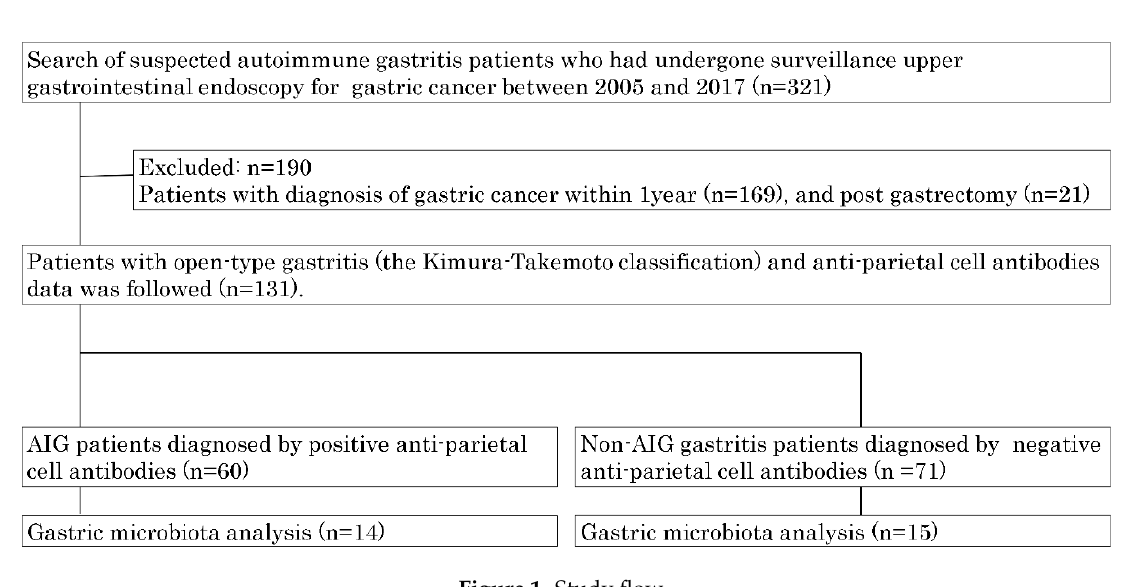
Figure 1. Study flow. Table 1. Characteristics between autoimmune gastritis (AIG) and non-AIG in patients.